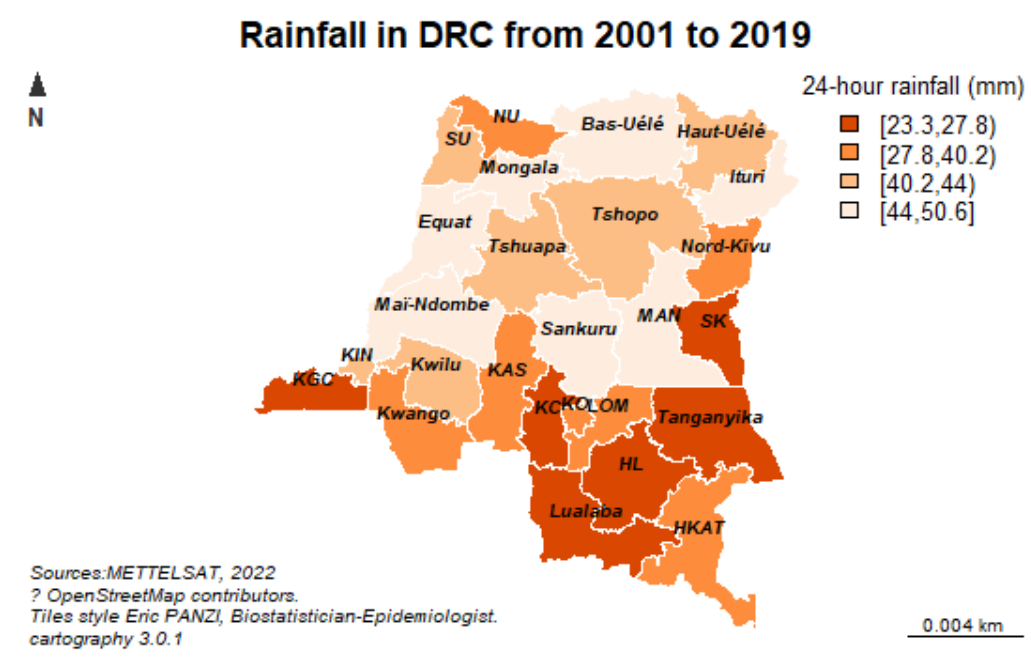
Figure A12. Rainfall (mm) in DRC from 2001 to 2019.